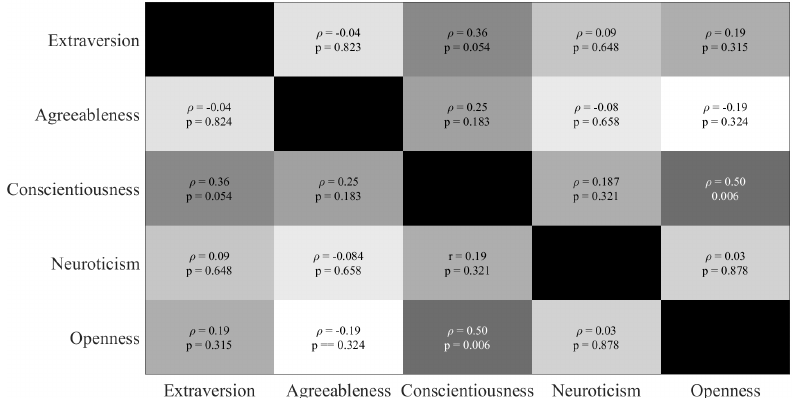
Figure A1. Pairwise Spearman correlations between participants’ personality traits: Extraversion, Agreeableness, Conscientiousness, Neuroticism, Openness. The Spearman correlation ρ along with its p- value in each cell correspond to the paired personality traits for that cell. We only observed a significant (uncorrected) correlation between “conscientiousness” and “openness”. All other correlations were non-significant.